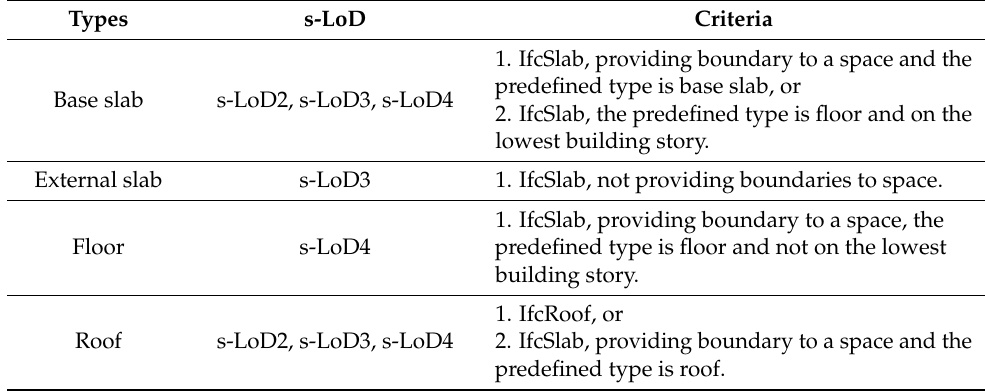
Figure 7. Decision tree for determining slab types, i.e., base slabs, floors, external slabs and roofs.